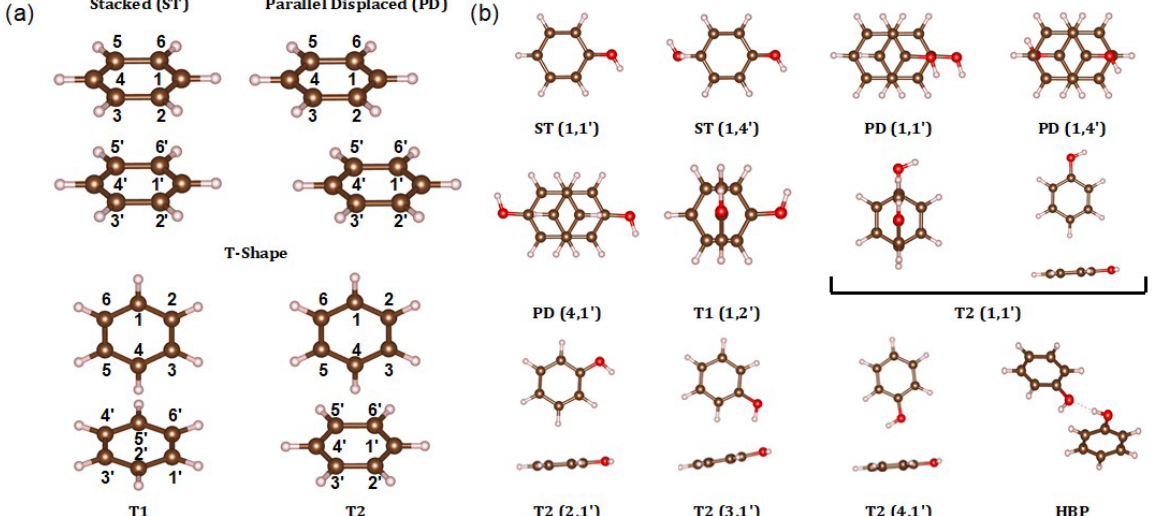
Figure 2. ( a ) Geometric conformations of benzene dimer. Each carbon from the upper (1~6) and lower (1′~6′) benzene is assigned a number. ( b ) Geometric conformations of phenol dimer. Each structure is designated by the position of the ring component (ST, PD, T1, T2, or HBP) and the number of substituted carbons with a hydroxyl group from the upper (1~6) and lower (1′~6′) phe- nol.